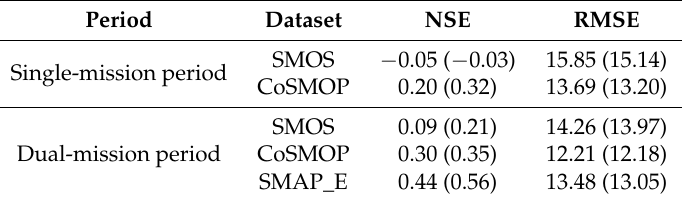
Table 1. Average performance (median NSE and mean RMSE) between SMOS-, SMAP_E- and CoSMOP-derived daily brightness Temperatures (Tbs) as compared to L-Band Microwave Emission of the Biosphere Model (L-MEB) simulations over 149 SCAN sites for a single-mission period (top) and a dual-mission period (bottom); the values in brackets are the metrics over 53 stations with almost continuous